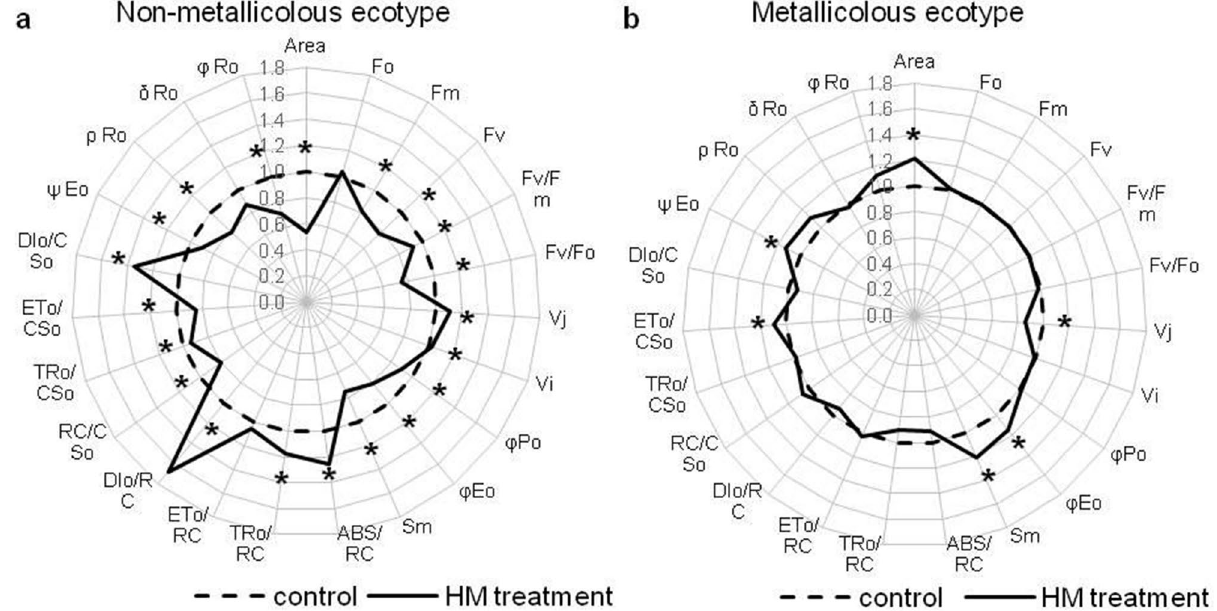
Figure 3. Structural and functional photosystem II parameters of Alyssum montanum leaves taken from non- metallicolous ( a ) and metallicolous ( b ) specimens, depending on treatment (control and heavy metals—HM); all the values were expressed relative to the control (set as 1); abbreviations—see Fig. 2; *statistically significant difference within each parameter in relation to control at P < 0.05 according to post hoc Tukey’s test.